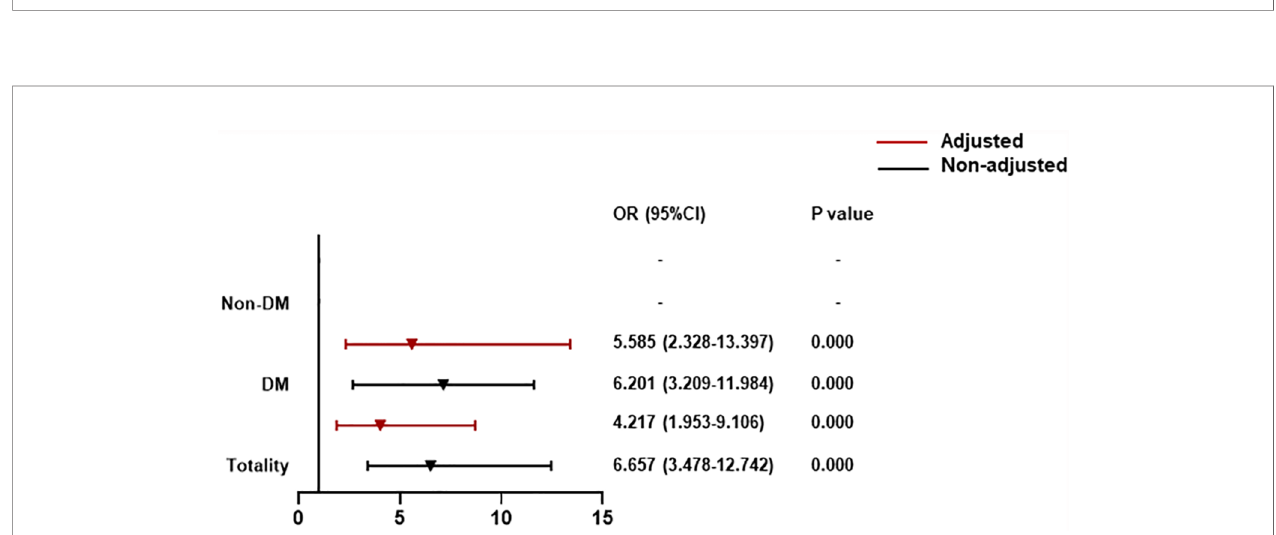
FIGURE 3 | The association between CysC rangeability and all-cause death classi fi ed by T2DM. CysC rangeability (changes in renal function) calculated as the difference in the CysC level between the time of hospital admission and the highest CysC level recorded during hospitalization. Adjusted by age, severe pneumonia, serum albumin, blood glucose, log NT-proBNP baseline. T2DM, type 2 diabetes mellitus; NT-proBNP, N terminal pro B type natriuretic